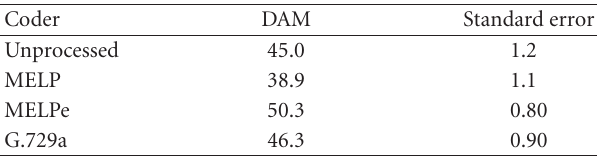
Table 2: DAM scores and standard error with vehicular noise (av- erage SNR ≈ 6dB).